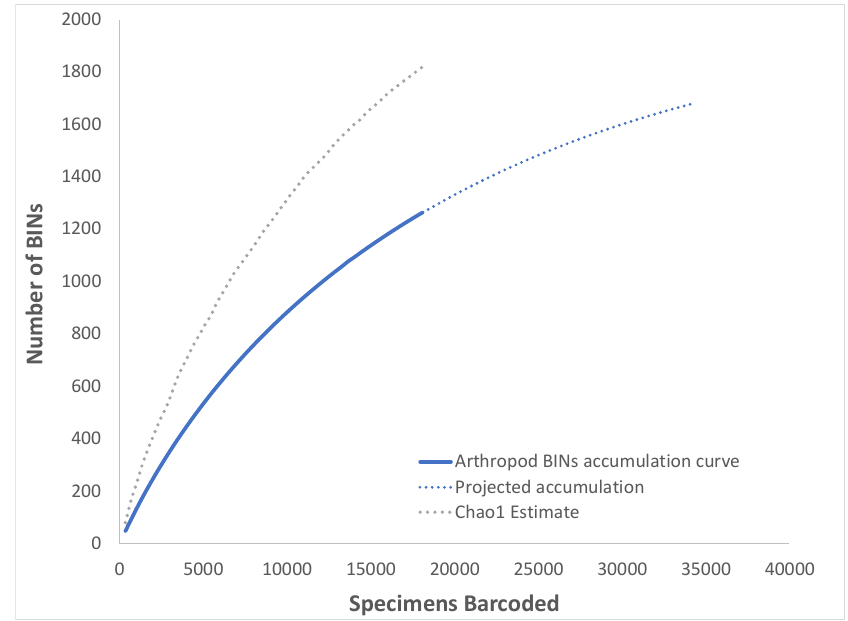
Figure 1. Estimated accumulation curve and overall taxonomic diversity assessment for all arthropods barcoded.